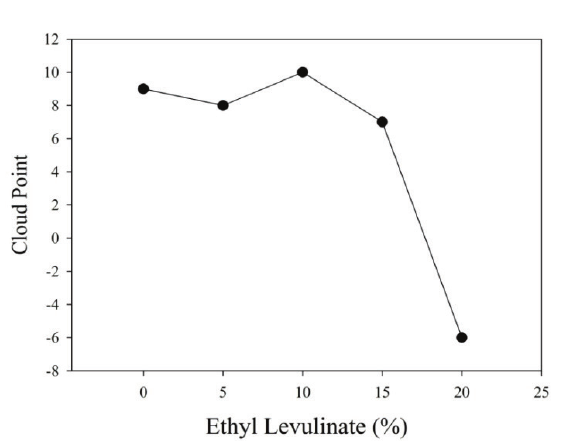
Figure 5: Effect of ethly levulinate amount on the cloud